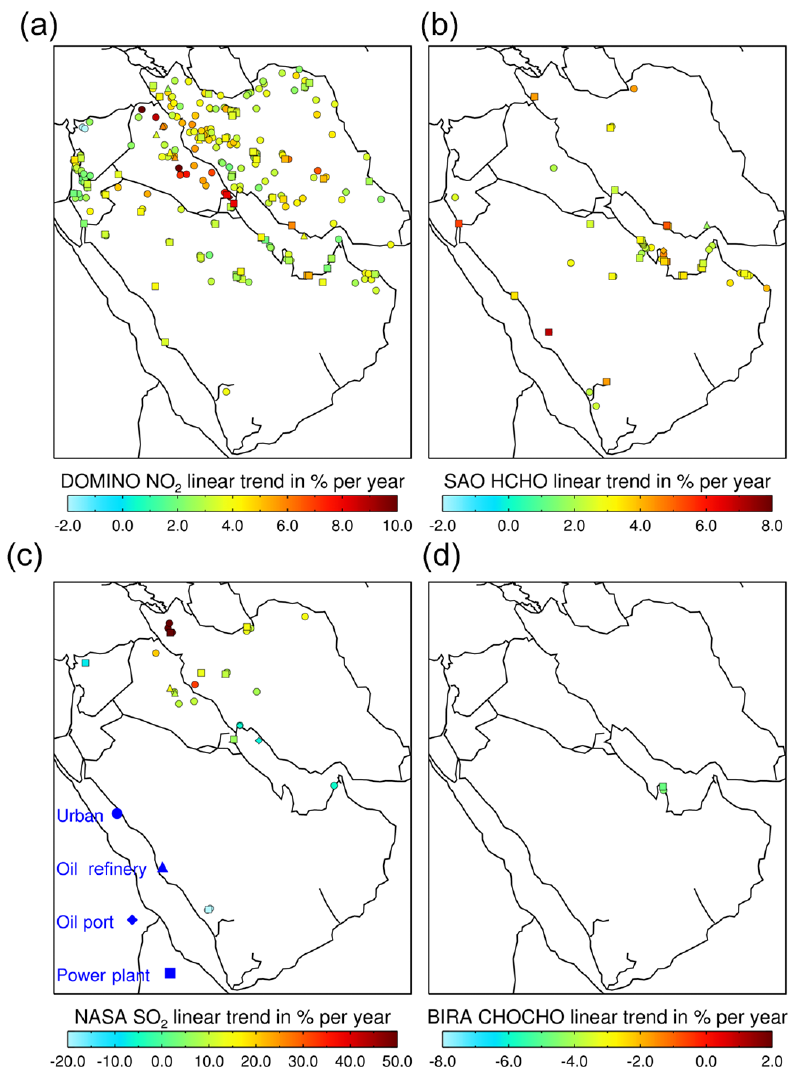
Figure 4. Geographical distribution of locations with statistically significant linear trends in NO 2 (a) , HCHO (b) , SO 2 (c) , and CHOCHO (d) expressed in percent per year, relative to each location’s 2005–2014 median vertical